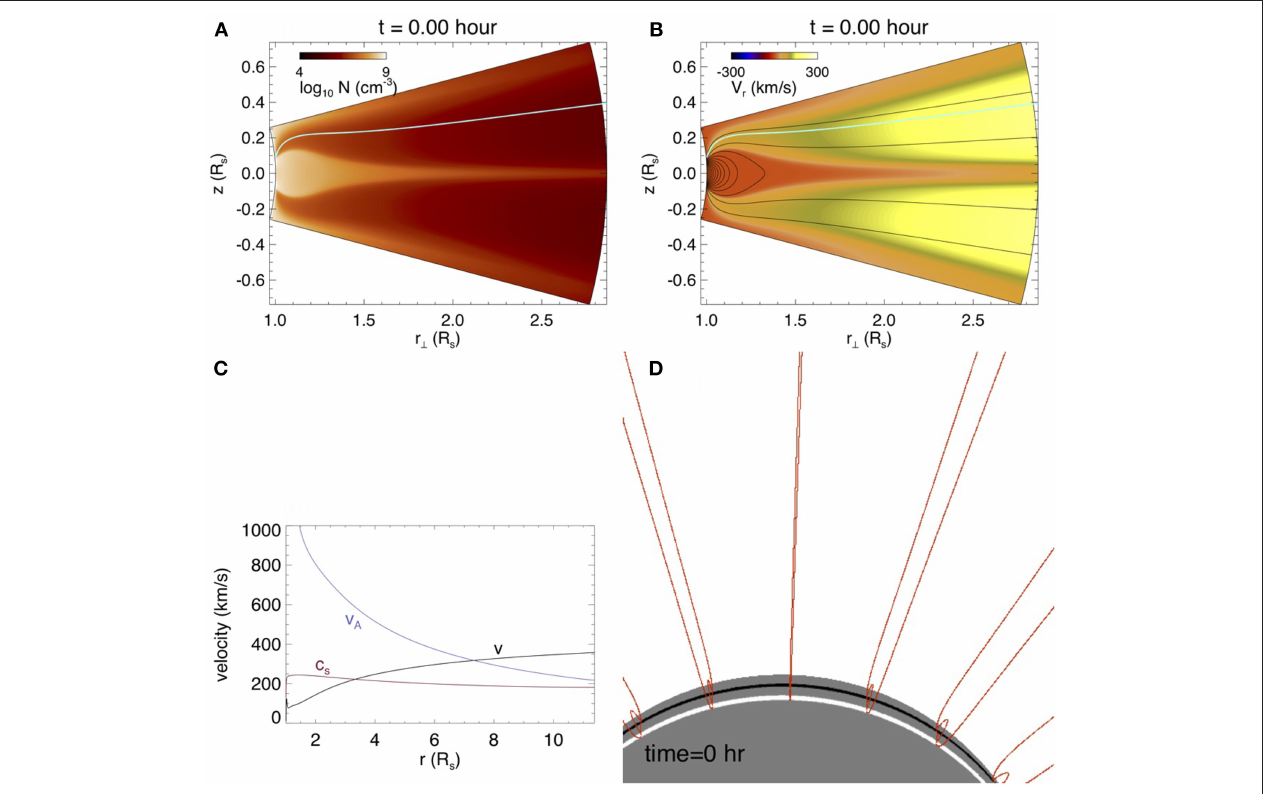
FIGURE 1 | The relaxed 2D quasi-steady streamer solution for the initial state. (A) shows the cross-section density, (B) shows the cross-section radial velocity over-plotted with magnetic field lines, (C) shows the parallel velocity V, the Alfvén speed V A , and sound speed C S along an open field line [marked as the green line in (A,B) ] in the ambient solar wind. (D) shows a 3D view of the initial streamer field lines in the simulation domain with the lower boundary color showing the normal flux distribution of the initial bipolar bands.